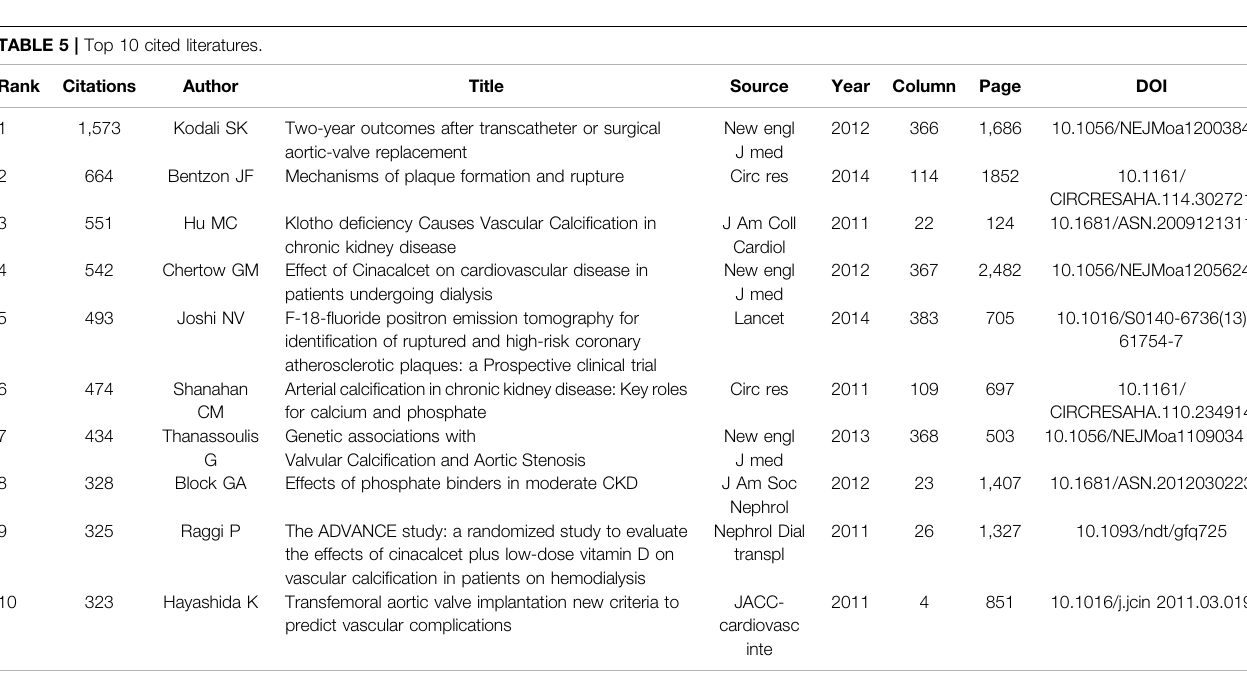
TABLE 5 | Top 10 cited